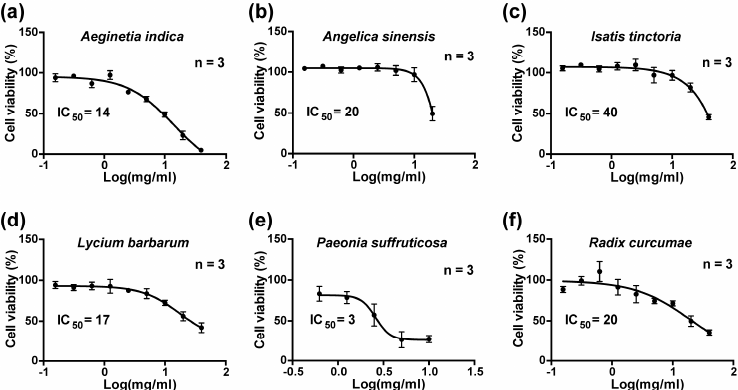
Figure 1. MTT-based cell viability assay for six herbal decoctions. The hepatitis C virus (HCV) host cells Huh7.5.1 were exposed to the decoction of ( a ) Aeginetia indica ; ( b ) Angelica sinensis ; ( c ) Isatis tinctoria ; ( d ) Lycium barbarum ; ( e ) Paeonia suffruticosa ; or ( f ) Radix curcumae for 72 h before being assayed for cell viability. Values are mean ± SEM (standard error of the mean) summarized from three independent experiments. Estimated 50% inhibitory concentrations (IC 50 ) in mg/mL are shown.